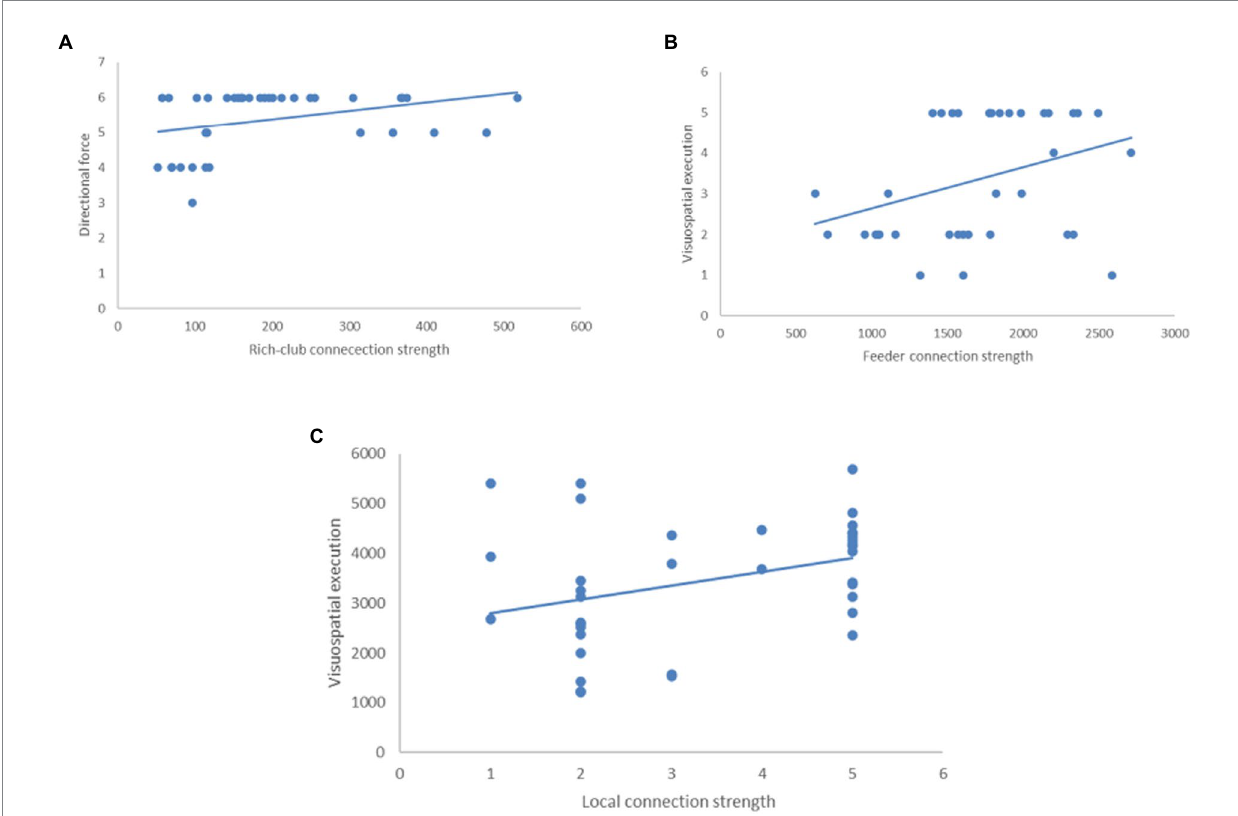
FIGURE 6 The relationship between connectivity of brain network and MoCA scale in the CHF + CI group. (A) The rich-club connection strength was related to the orientation (direction force; p = 0.043). (B) The feeder connection strength was related to Visuospatial/Executive function ( p = 0.032). (C) The local connection strength was related to Visuospatial/Executive function ( p = 0.032, B; p =